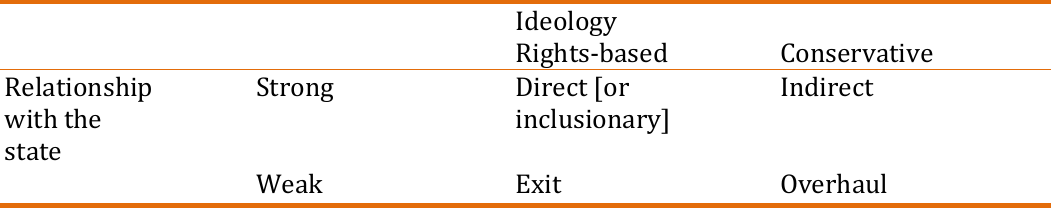
Table 01. Interaction between ideology and relationship with the State: effect on strategies